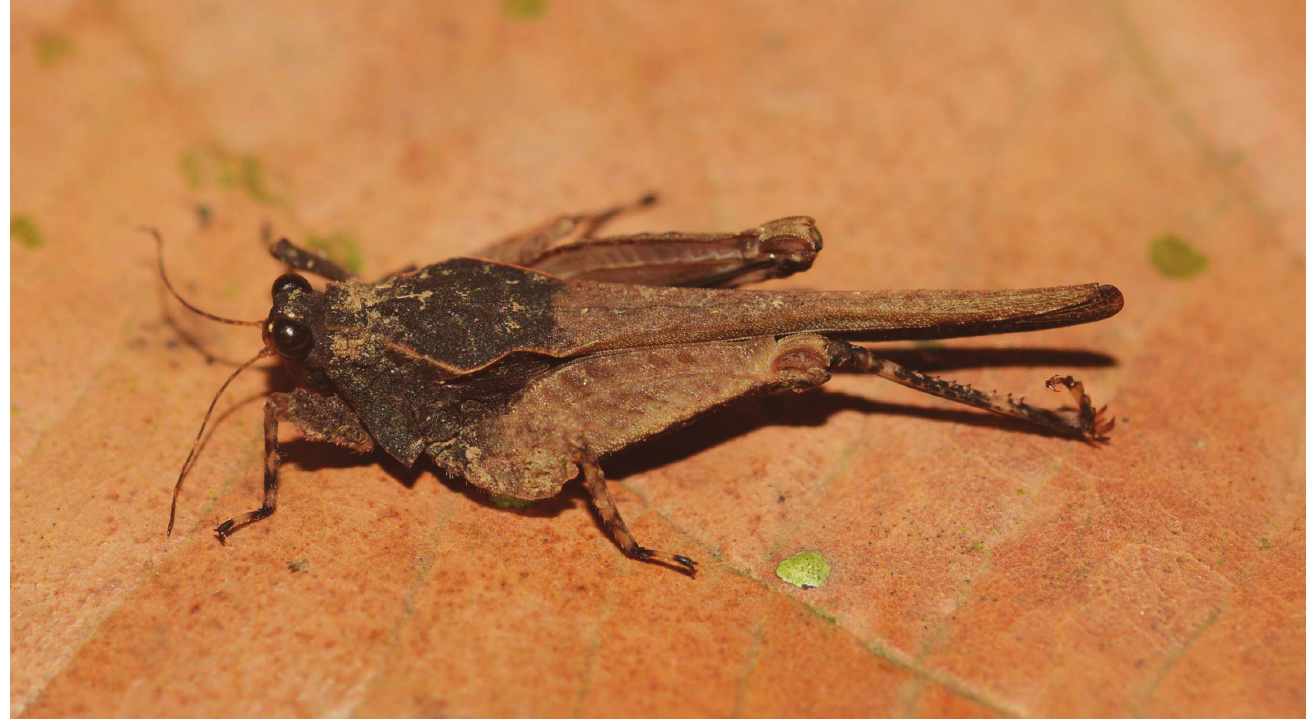
Fig. 11. Live Eomorphopus antennatus male from Brazilian